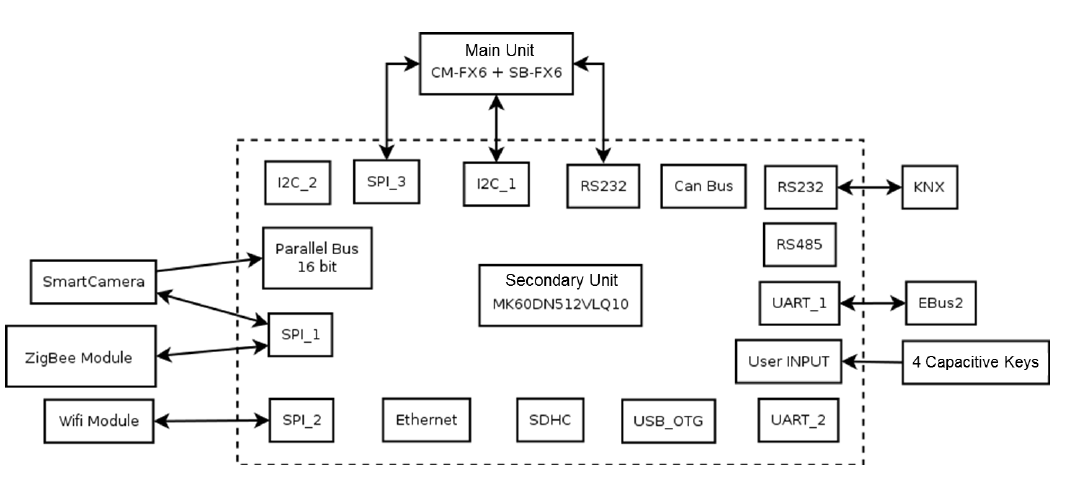
Figure 8. Block diagram of secondary unit interfaces of the HDOMO